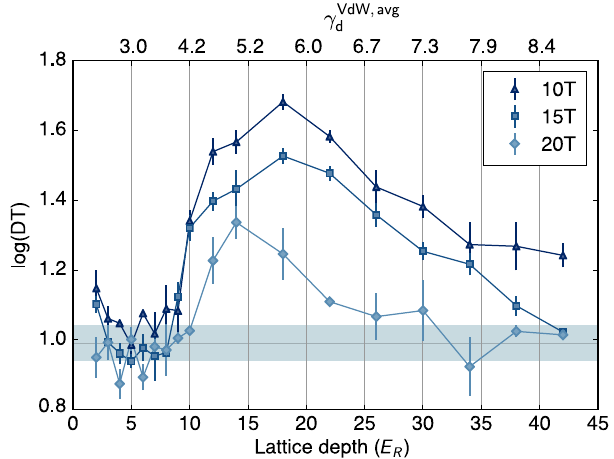
FIG. 8. Thermalization distance at θ ¼ 90 ° measured as a function of lattice depth for different observation times: 10 T (triangle), 15 T (square), and 20 T (diamond). The blue band represents the noise floor and its 1 σ uncertainty. The γ VdW ; avg associated with the lattice depths are shown on top.